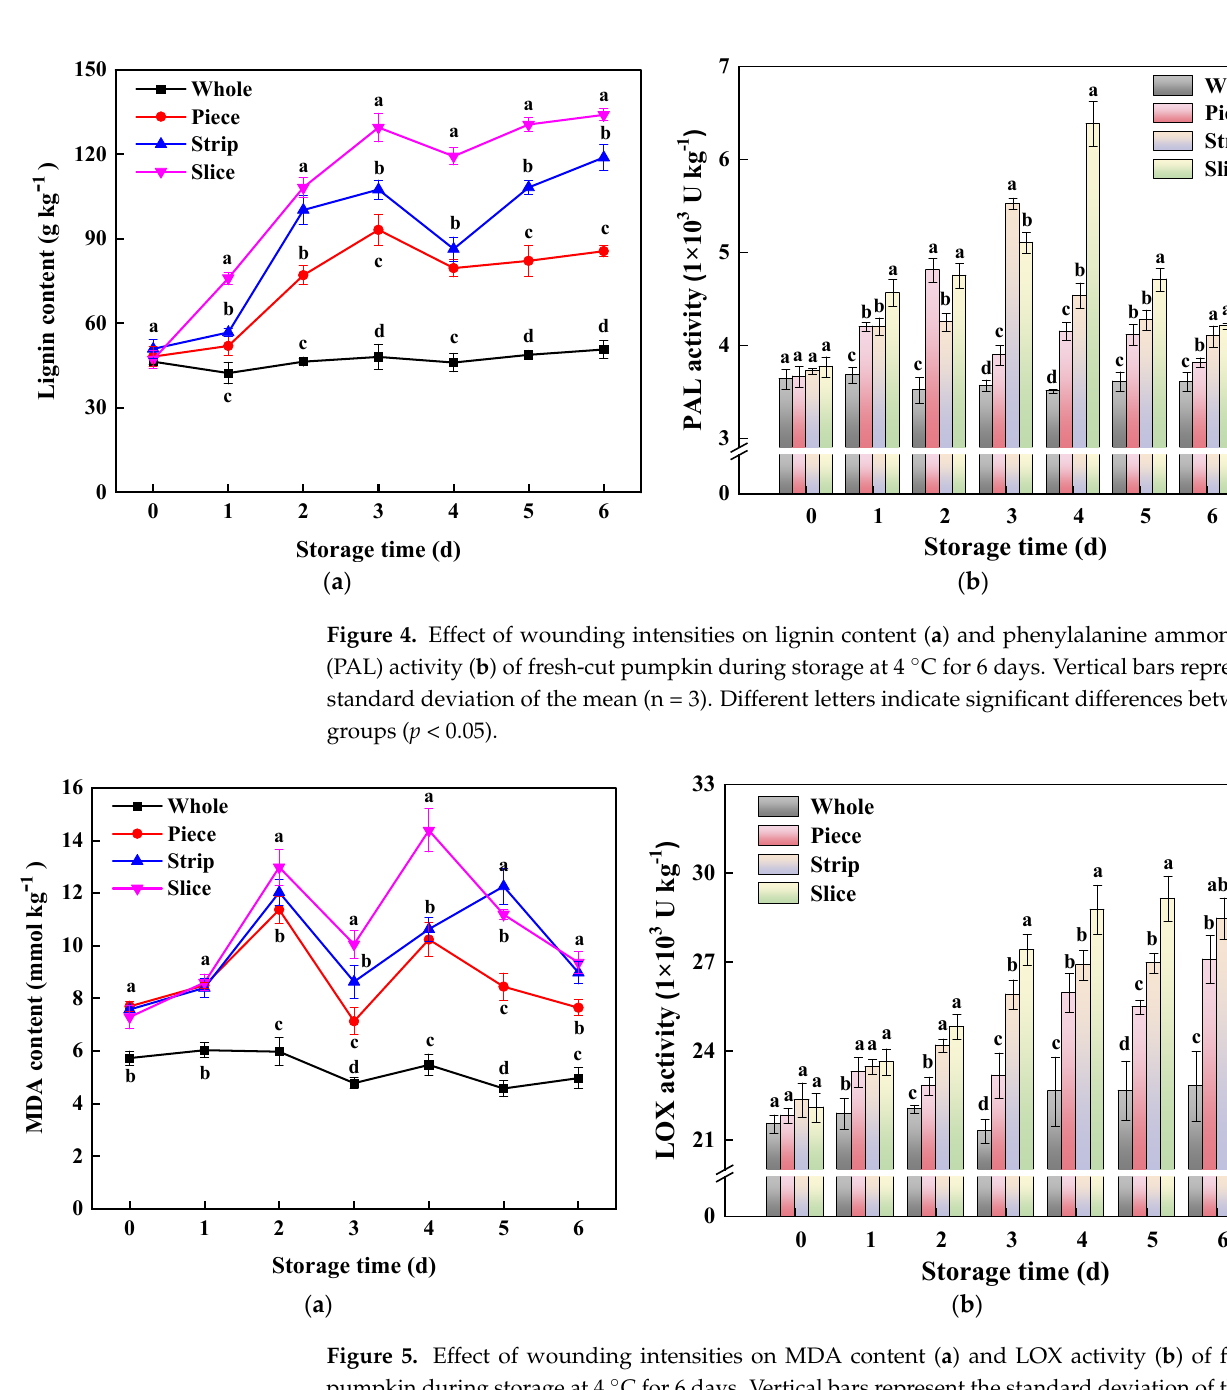
Figure 5. Effect of wounding intensities on MDA content ( a ) and LOX activity ( b ) of fresh-cut pumpkin during storage at 4 °C for 6 days. Vertical bars represent the standard deviation of the mean (n = 3). Different letters indicate significant differences between the groups ( p < 0.05).